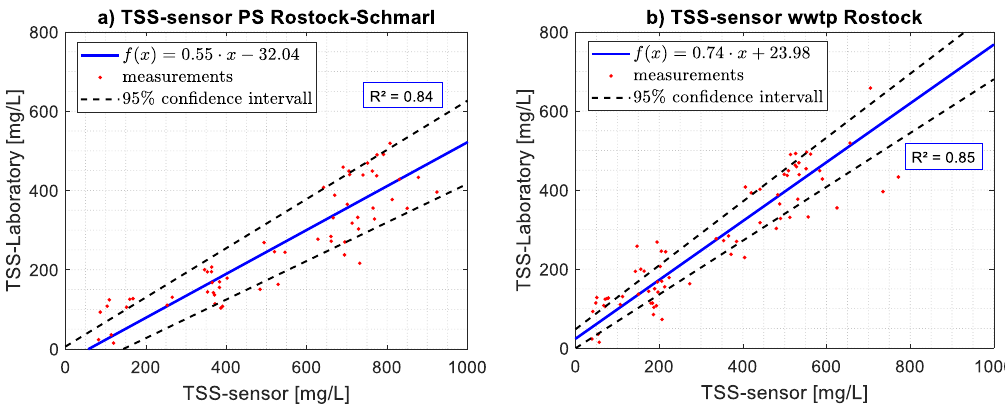
Figure 4. Calibration functions for calculating laboratory TSS values from in-situ measured sensor TSS values, including goodness of fit ( R 2 ) and 95% confidence interval. ( a ) For TSS sensor in PS Rostock-Schmarl. ( b ) For TSS sensor at the central wwtp Rostock.